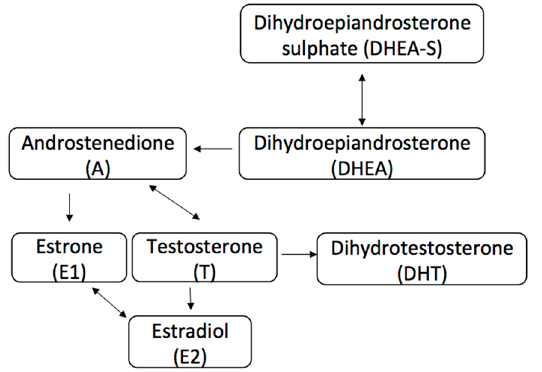
Figure 1. Abbreviated androgen and estrogen pathway. Arrows represent direction of enzymatic